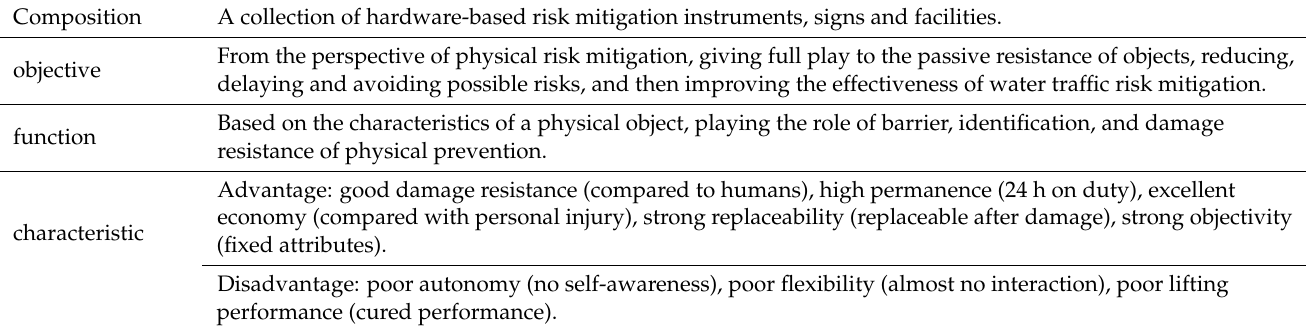
Table 2. Details of the physical defence subsystem of the